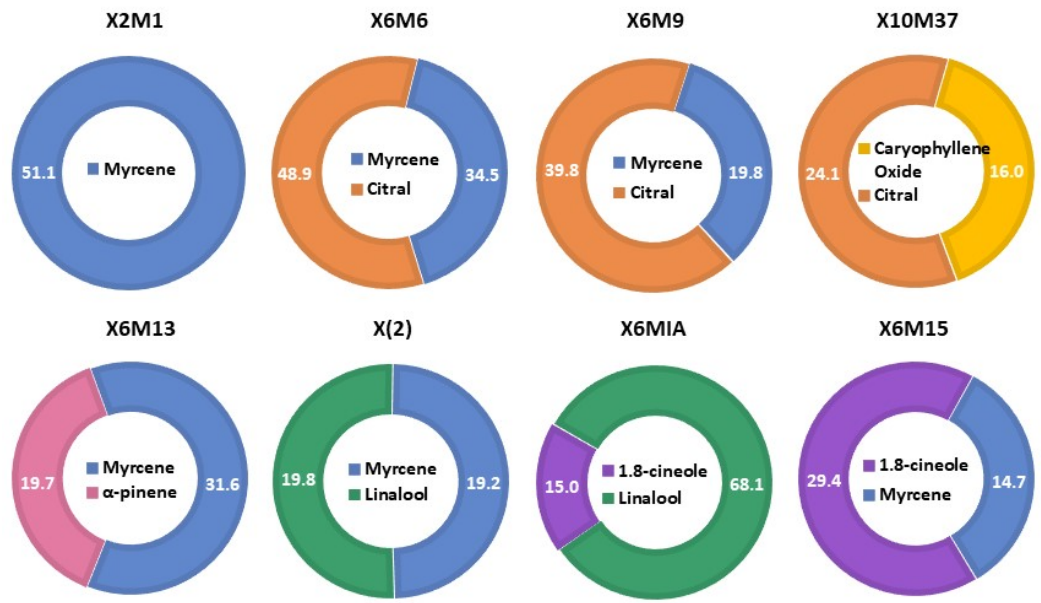
Figure 1. Major compounds and its relative percentage (%) in the genotypes of L. alba .